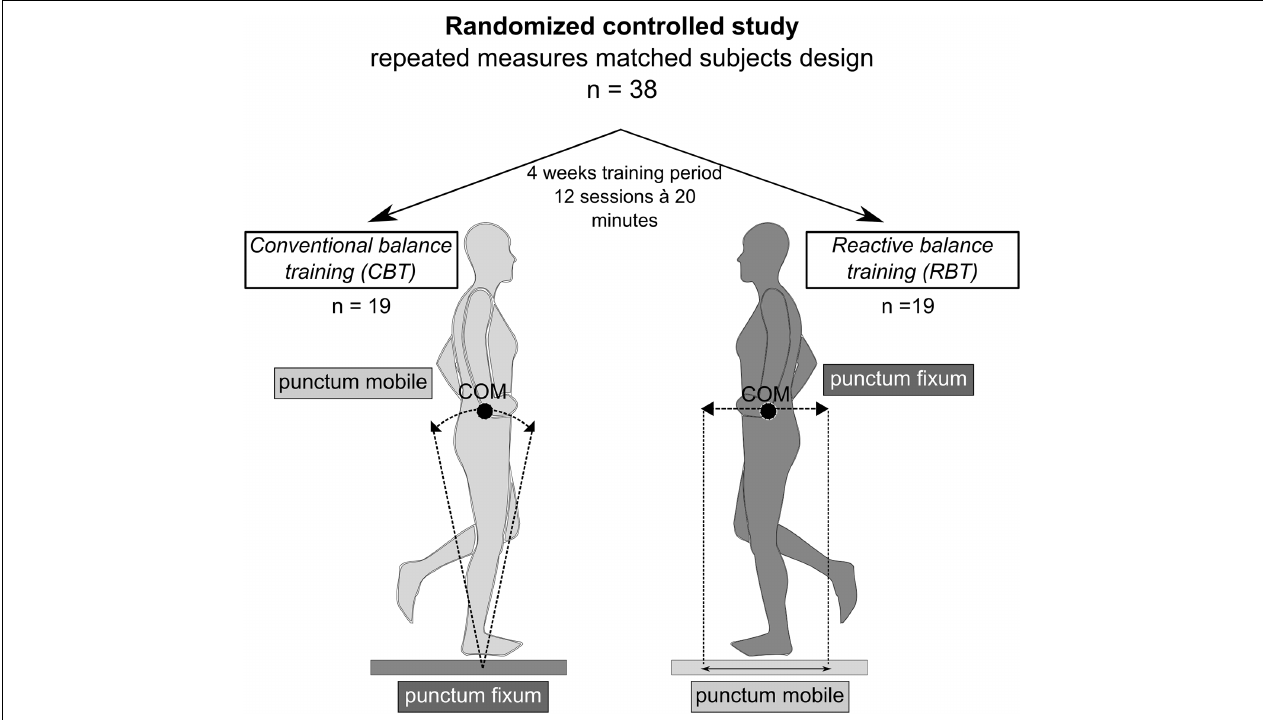
FIGURE 1 | Study overview and models comparing conventional versus reactive balance training. Comparison of the two training paradigms on the basis of pendulum models (Winter, 1995; Schmitt, 2003) with the conventional training (CBT) describing a single inverted pendulum, while participants in the reactive balance training (RBT) group oscillate around the fixation point located within the center of gravity. In this randomized controlled study, baseline data collection was followed by a random “matched-pair” assignment of 39 volunteers to either the CBT-group or RBT-group. Before and after 4 weeks of training, measurements were conducted to assess changes in fall-related risk